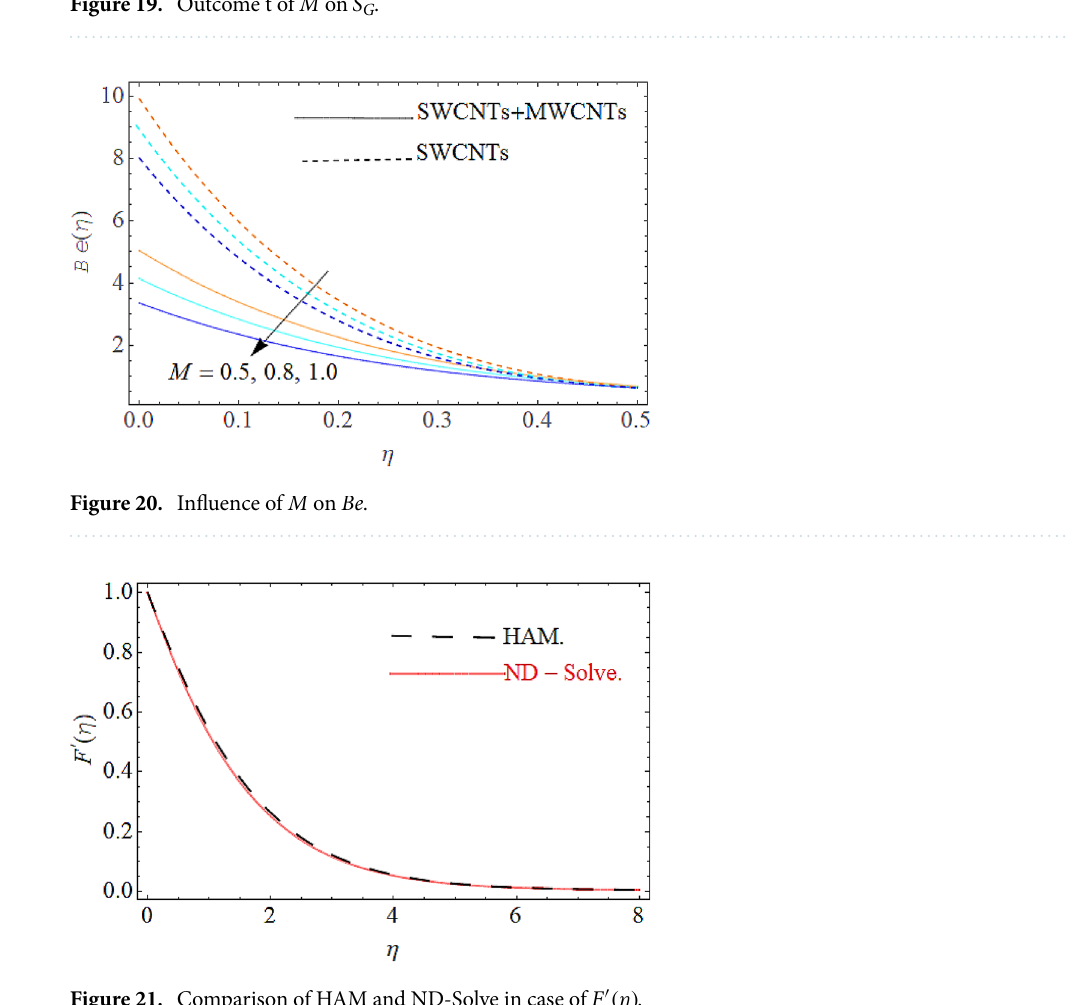
Figure 19. Outcome t of M on S G .